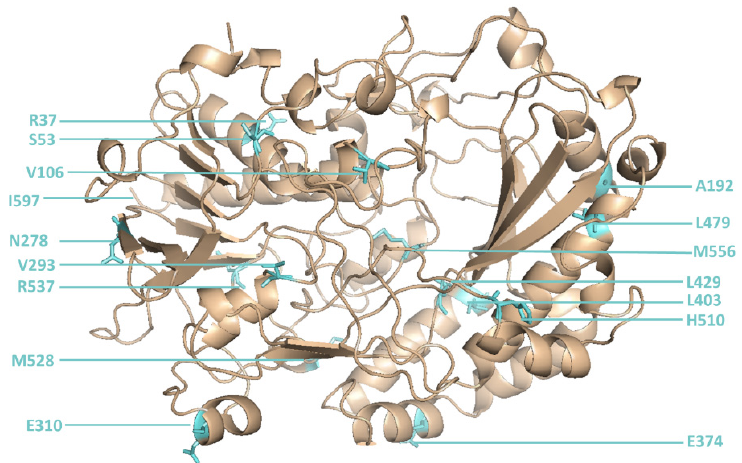
Figure 2. The 16 positions in glucose oxidase that were changed by site-directed mutagenesis.